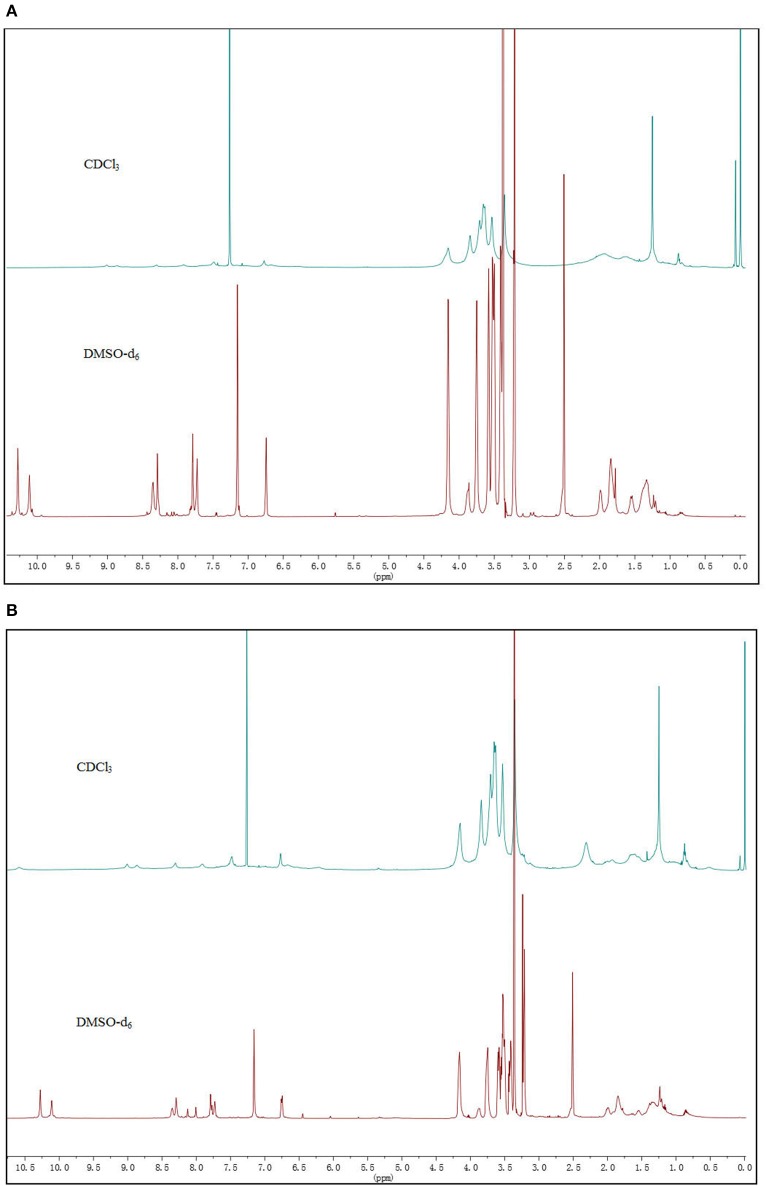
The 1H NMR spectra of CPs in DMSO and CDCl3: (A) 2 and (B) 3.